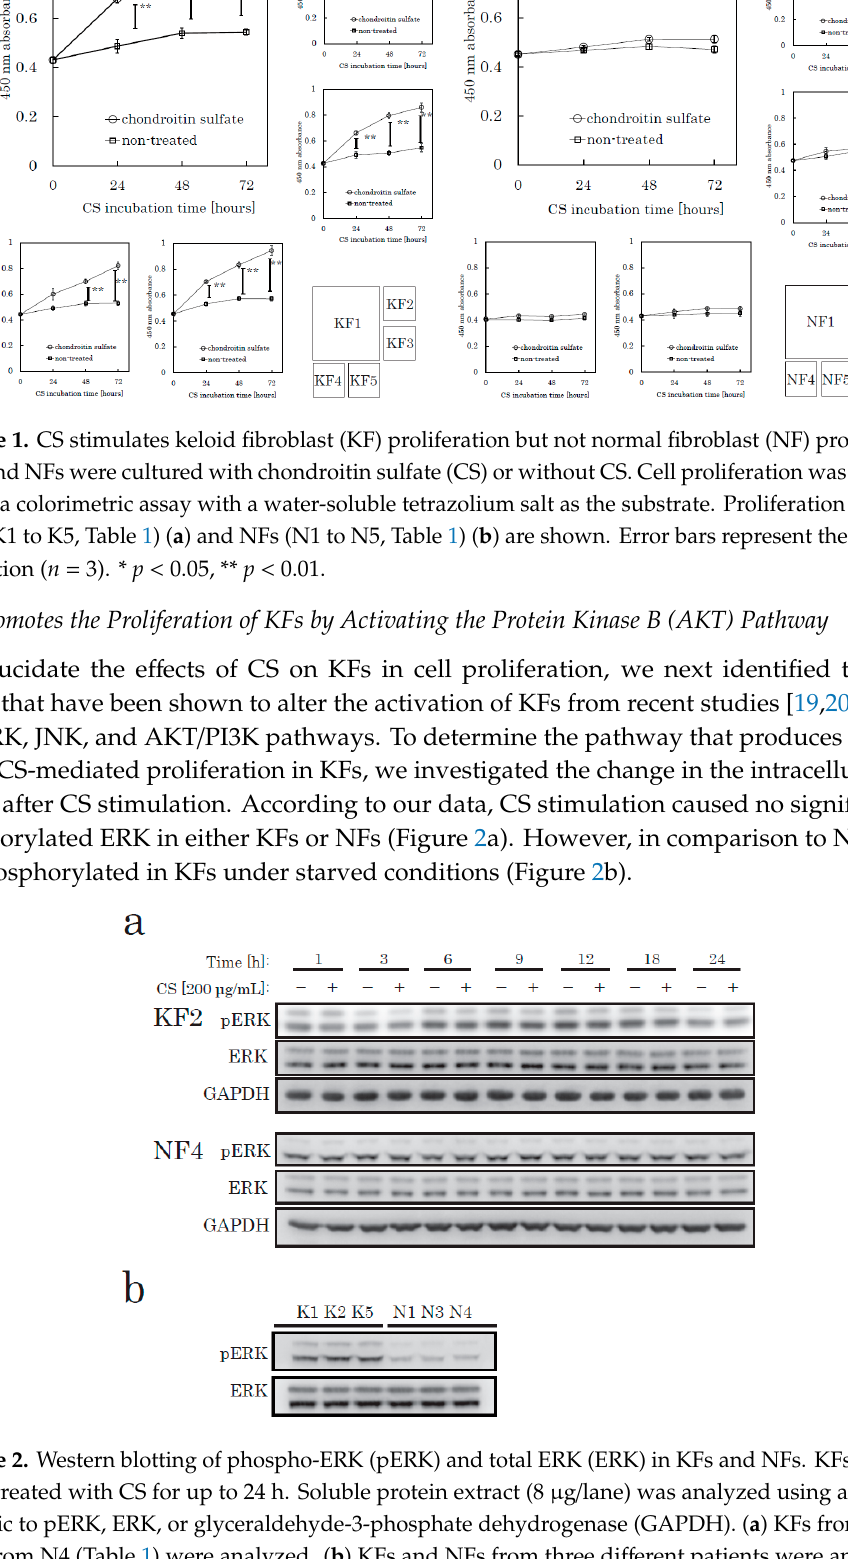
Figure 2. Western blotting of phospho-ERK (pERK) and total ERK (ERK) in KFs and NFs. KFs and NFs were treated with CS for up to 24 h. Soluble protein extract (8 µ g / lane) was analyzed using antibodies specific to pERK, ERK, or glyceraldehyde-3-phosphate dehydrogenase (GAPDH). ( a ) KFs from K2 and NFs from N4 (Table 1) were analyzed. ( b ) KFs and NFs from three di ff erent patients were